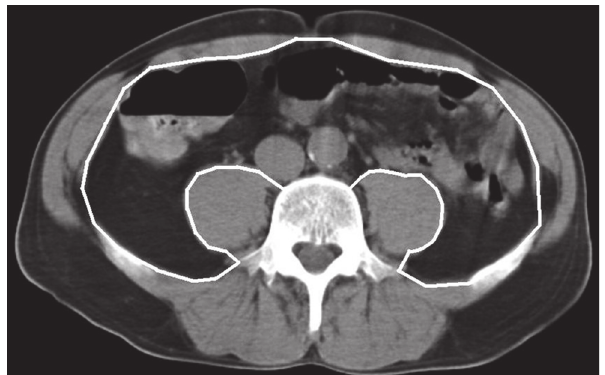
Fig 2. The image illustrates how the area of visceral adipose tissue (VAT) within the abdominal cavity (white line) was determined by CT scanning. Pixels with the density of adipose tissue between − 30 and − 190 Hounsfield Units (HU) were included in the VAT area calculated automatically by the CT software. In the illustrative case, the VAT area is 110 cm 2